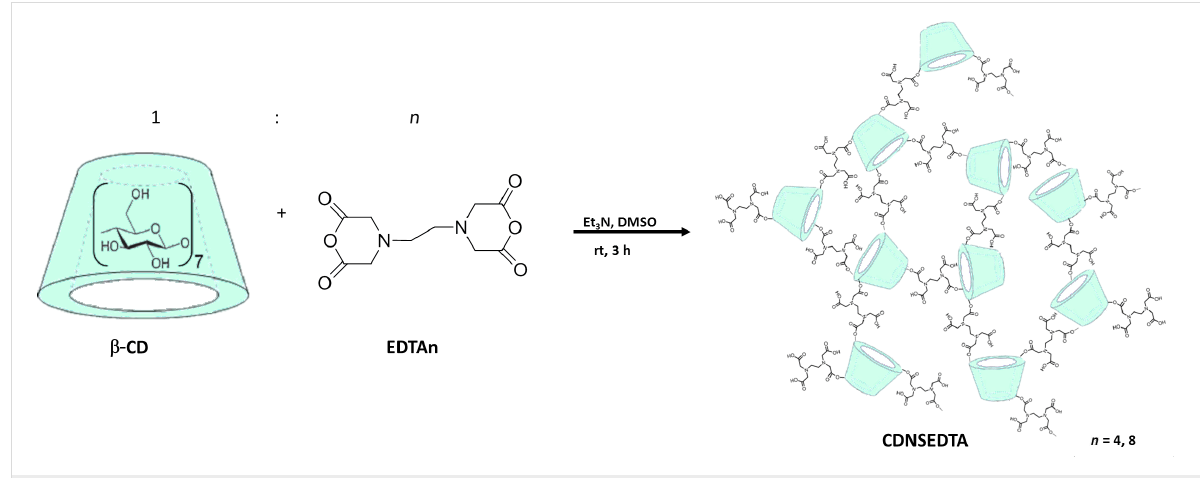
Scheme 1: Schematic representation of the nanosponge synthesis. Acronyms: β -CD: β -cyclodextrin; EDTAn: anhydride of EDTA; CDNSEDTA: cyclodextrin nanosponge obtained by using EDTAn as